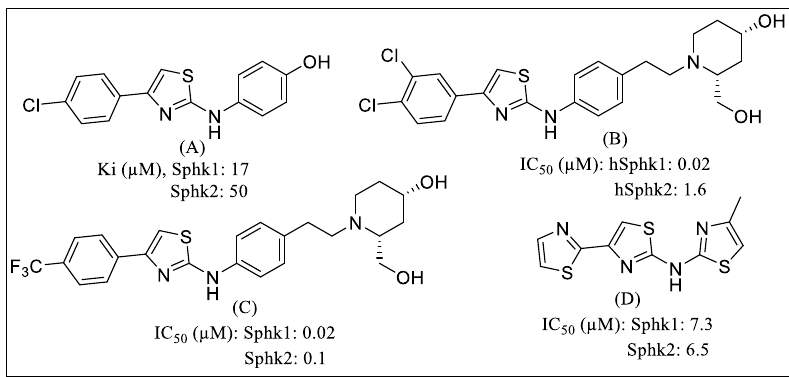
Figure 1. Chemical structure of thiazole-based sphingosine kinase 1 inhibitor.